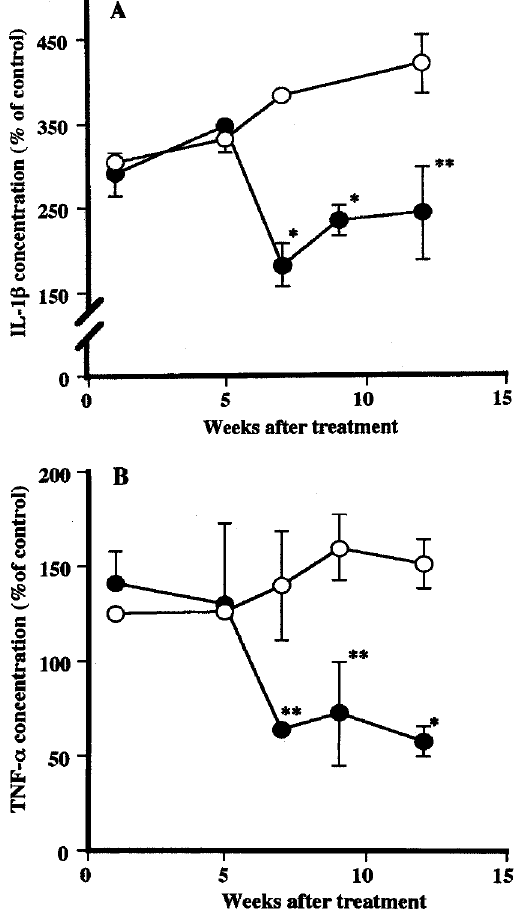
FIG. 5. Inhibition of pro-inflammatory cytokine appearance in aqueous lung extracts prepared from mice pretreated with RXM. BALB/c mice were orally administered with 2.5mg/kg RXM for various periods. Mice were injected intratracheally with 1.0 m g/ml LPS in a volume of 0.1ml. After 24h, lungs were obtained and homogenized in 1.0ml PBS to examine the concentration of IL-1 b (A) and TNF- a (B). Cytokine concentrations were assayed by ELISA, and the results were expressed as mean percent of control (PBS-instilled)±SD of five individual mice. s : treated with vehicle alone, d : treated with RXM. * P <0.001, ** P